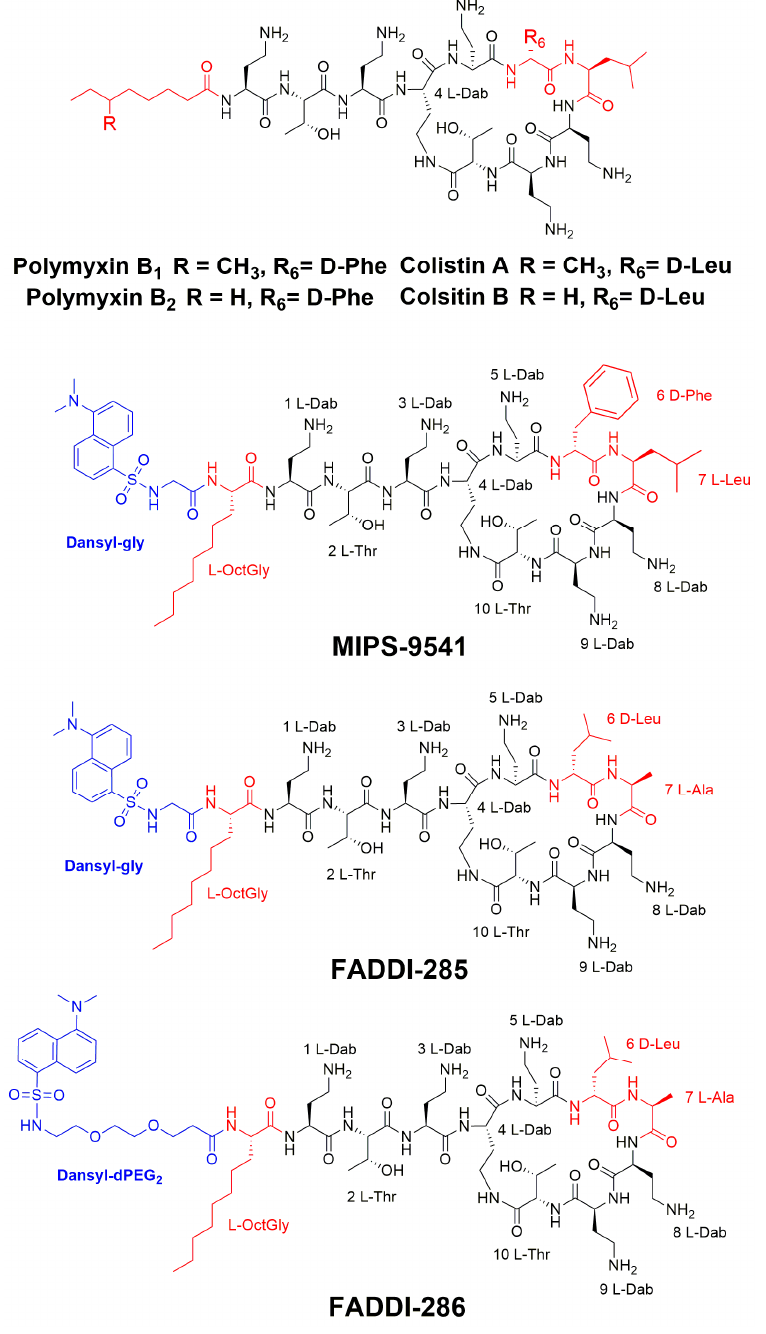
Figure 1. Structures of polymyxin B, colistin, MIPS-9541 and the novel fluorescent polymyxin probes FADDI-285 and FADDI-286.